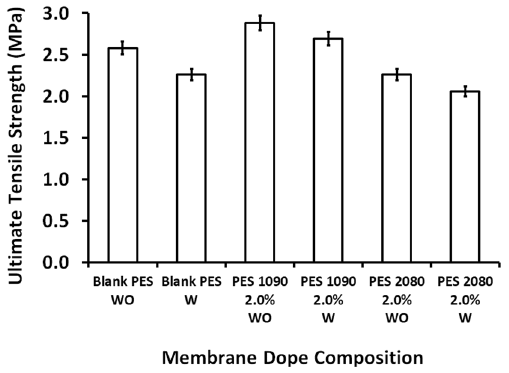
Figure 13. Ultimate tensile strength as a function of the membrane dope composition of both the blank PES and the magnetic mixed matrix PES membranes without (WO) and with (W) 0.1 wt% of Lithium chloride additive in the membrane